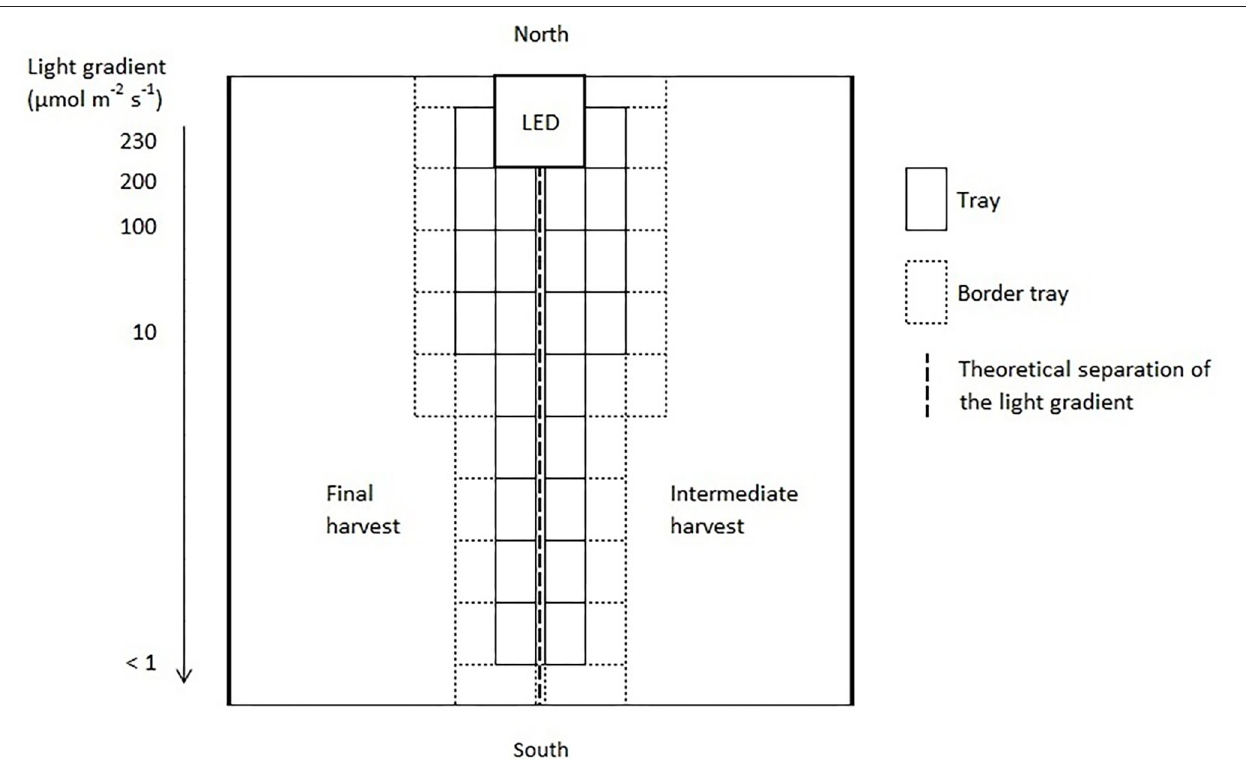
FIGURE 2 | Schematic representation of one light quality treatment of the supplemental lighting setup. The positions of the light quality treatments and harvests were randomized in each replication and season.